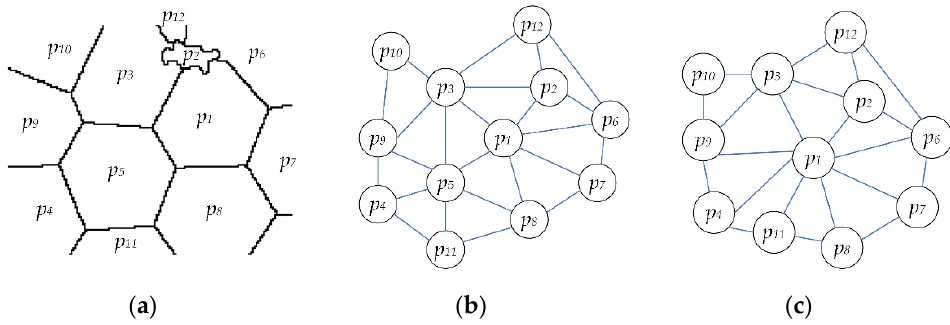
Figure 9. Example of RAG in a local region. ( a ) A local region in the initial segmented map; ( b ) the corresponding RAG; and ( c ) the next RAG after merging p 1 and p 5 , if the weight w is greater than w T .